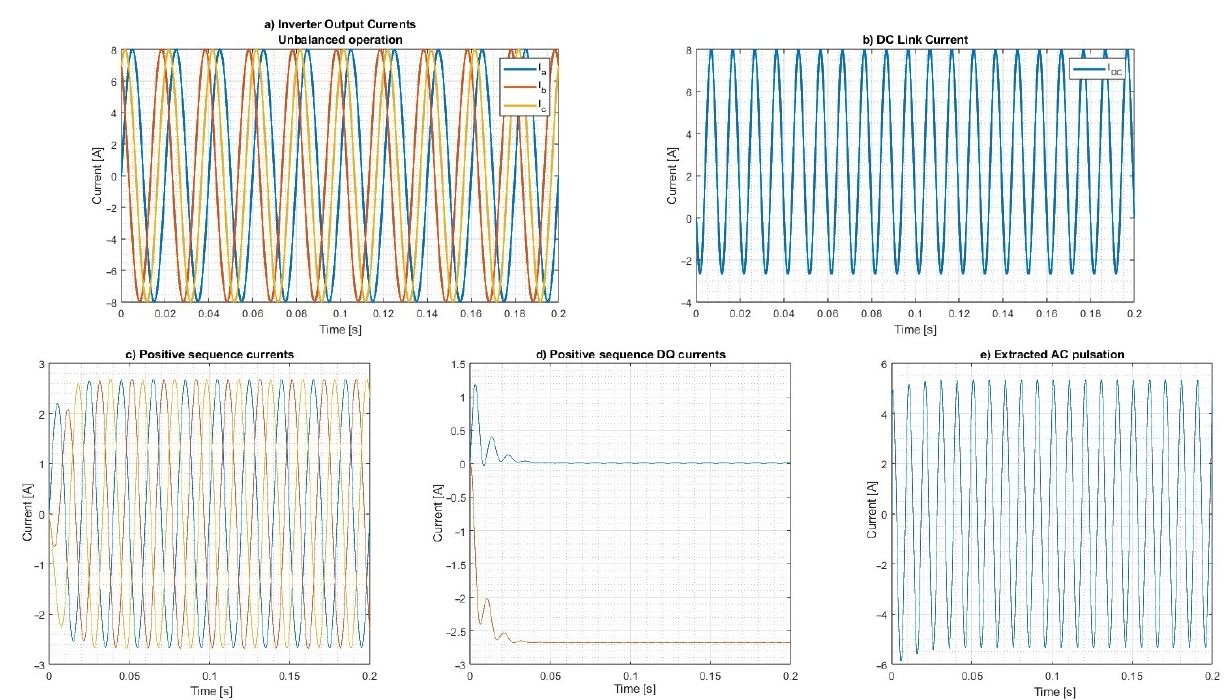
Figure 8. Evaluation of the implementation of the current pulsation extraction.